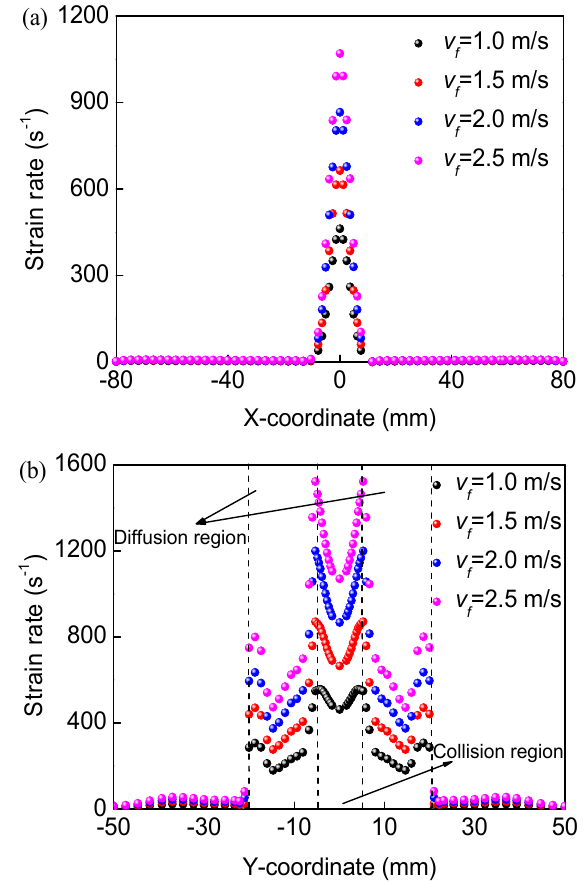
Figure 4. Strain rate distributions of the CFPCD at various lines: ( a ) line (Y = 0 mm, Z = 0 mm) and ( b ) line (X = 0 mm, Z = 0 mm).